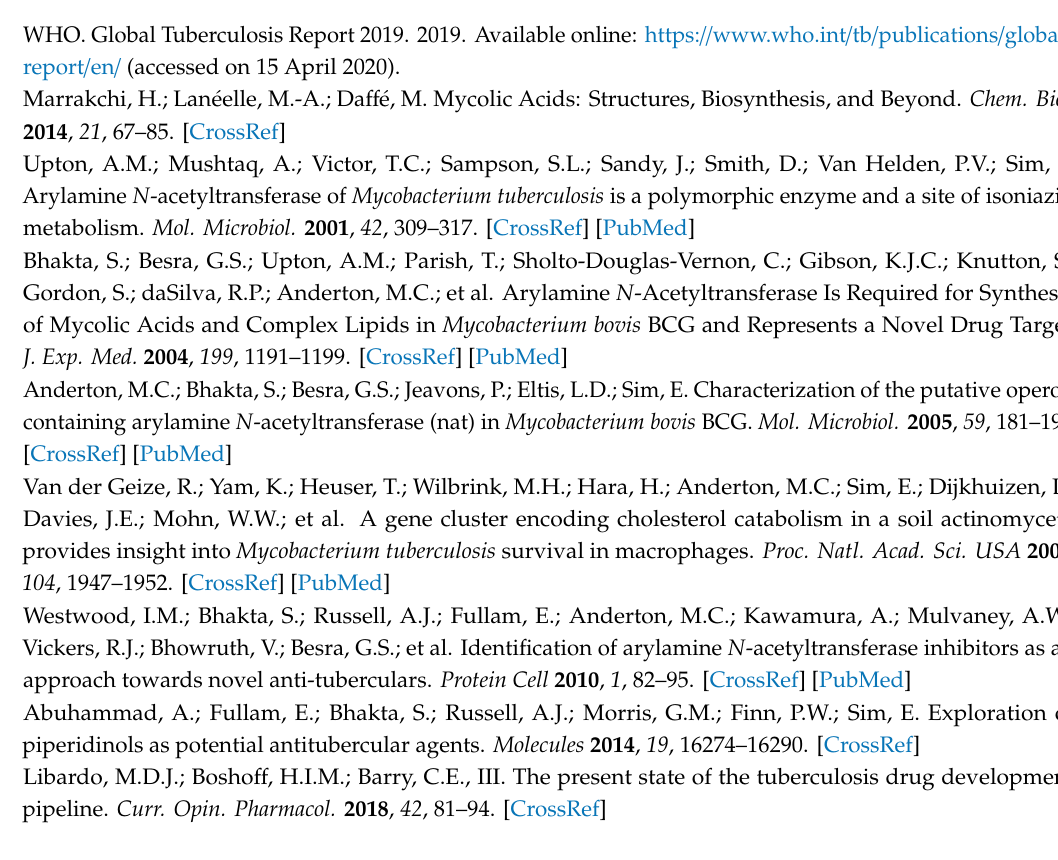
Figure S1: Enzyme inhibition plots of compounds 1, 2 and 3 against M. marinum